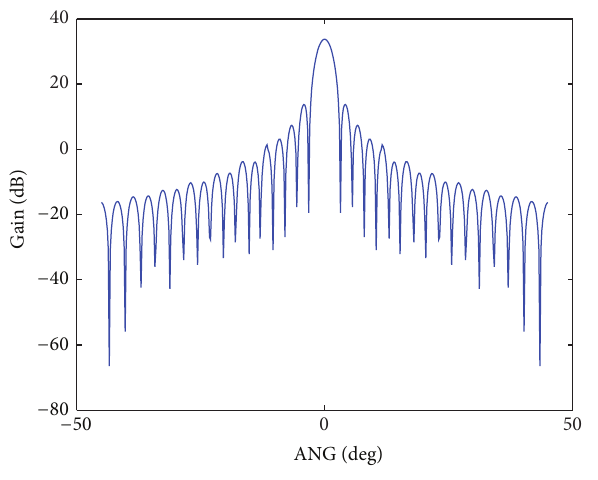
Figure 2: The pattern of antenna beam. Table 1: The parameters settings of simulation.